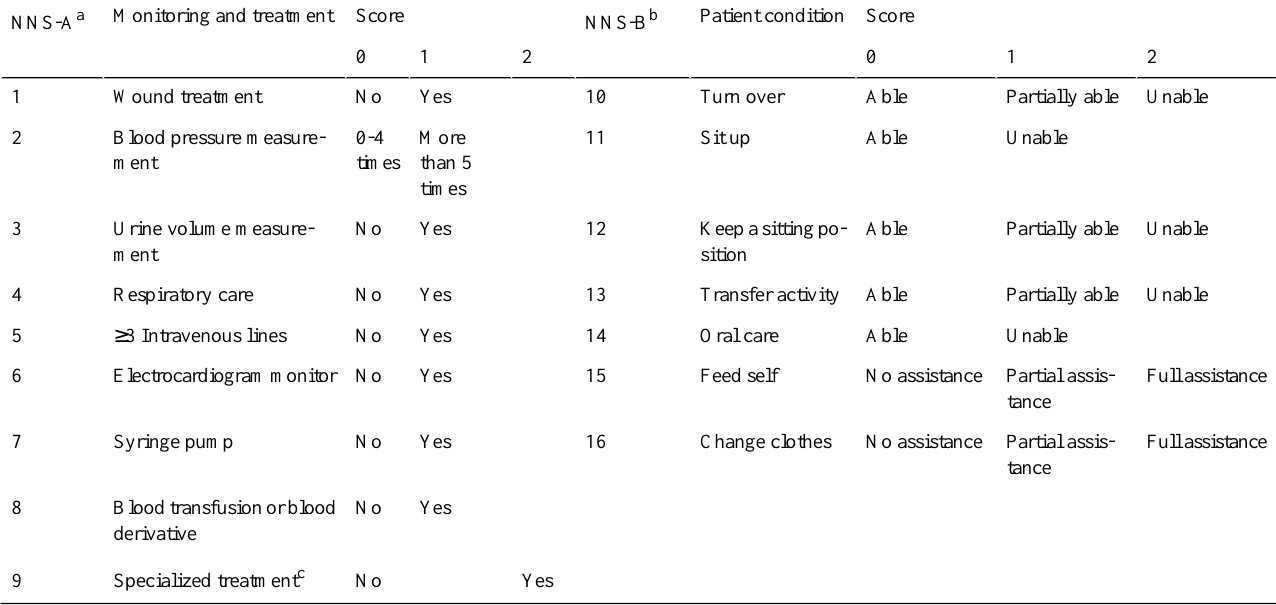
Table 1. NNS items in general